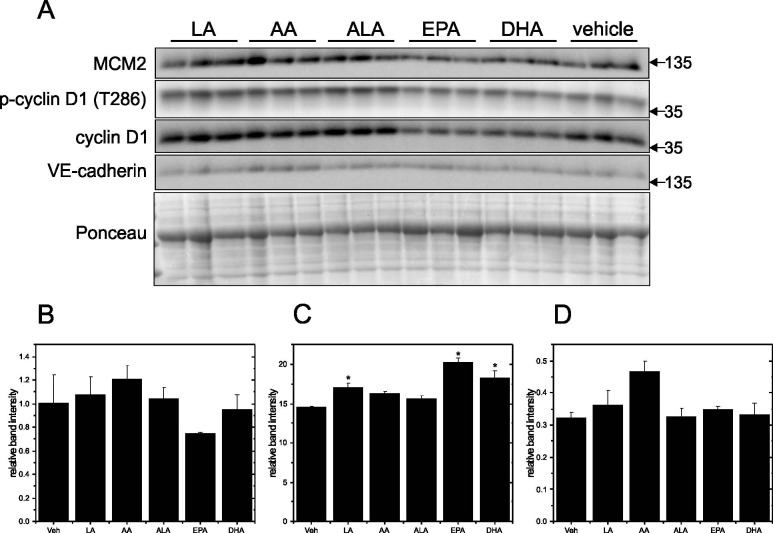
Effect of PUFA treatment on MCM2, p-cyclin D1, cyclin D1 and VE-cadherin in confluent EA.hy926 cells grown on Matrigel-coated plates.EA.hy926 endothelial cells were seeded on Matrigel-coated plates at 9000 cells/cm2 and grown for 8 days. Cells were treated with PUFAs (LA, AA, ALA, EPA and DHA) individually at 125 μM for 8 h. Protein levels of MCM2, p-cyclinD1, cyclin D1 and VE-cadherin were determined by Western blotting of cell lysates prepared after treatments. Representative blots are shown in Panel A. Densitometry was used to quantify the intensity of the bands in the upper panel and data were normalized to a band visualized by Ponceau staining. Data are presented as means ± SEM (n = 3) for MCM2 (Panel B), p-cyclin D1/cyclin D1 (Panel C) and VE-cadherin (Panel D). *Significantly different (p <0.05) from vehicle control.